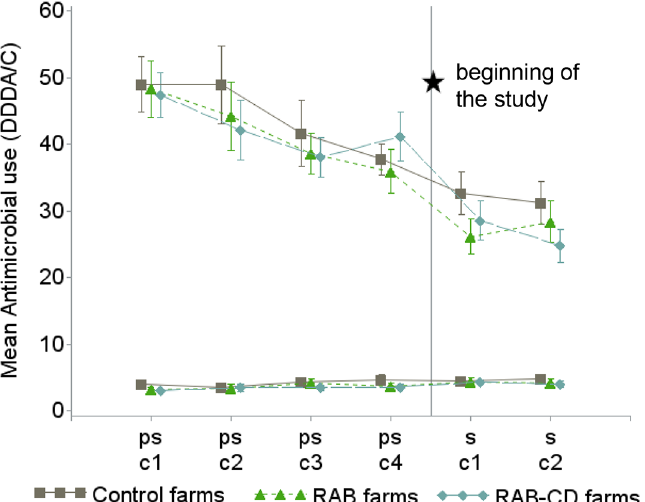
Fig 1. Mean antimicrobial use (as defined daily dosages per animal and cycle (DDDA/C)) and 95% confidence interval in 51 veal calf farms during 4 pre-study production cycles (ps-c1 to ps-c4) and the 2 study cycles (s-c1 and s-c2) for group treatments (3 upper lines) and individual treatments (3 lower lines), the Netherlands 2009 – 2012. For assessing baseline comparability, study arms are also shown during the pre-study cycles before assignment to any intervention. RAB , farms reducing antimicrobials by protocol; RAB-CD , farms reducing antimicrobials by protocol and applying a cleaning and